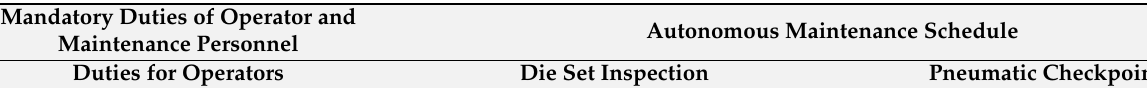
Table 5. Mandatory duties of operator and maintenance